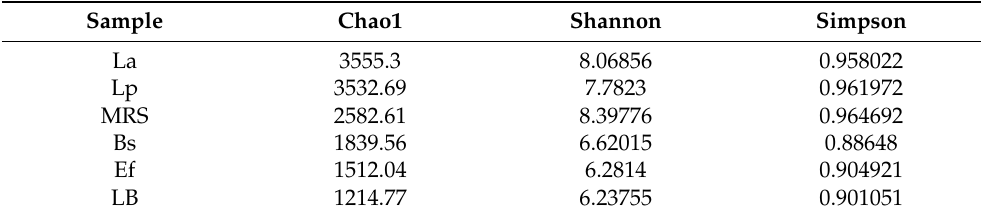
Table 4. α -diversity